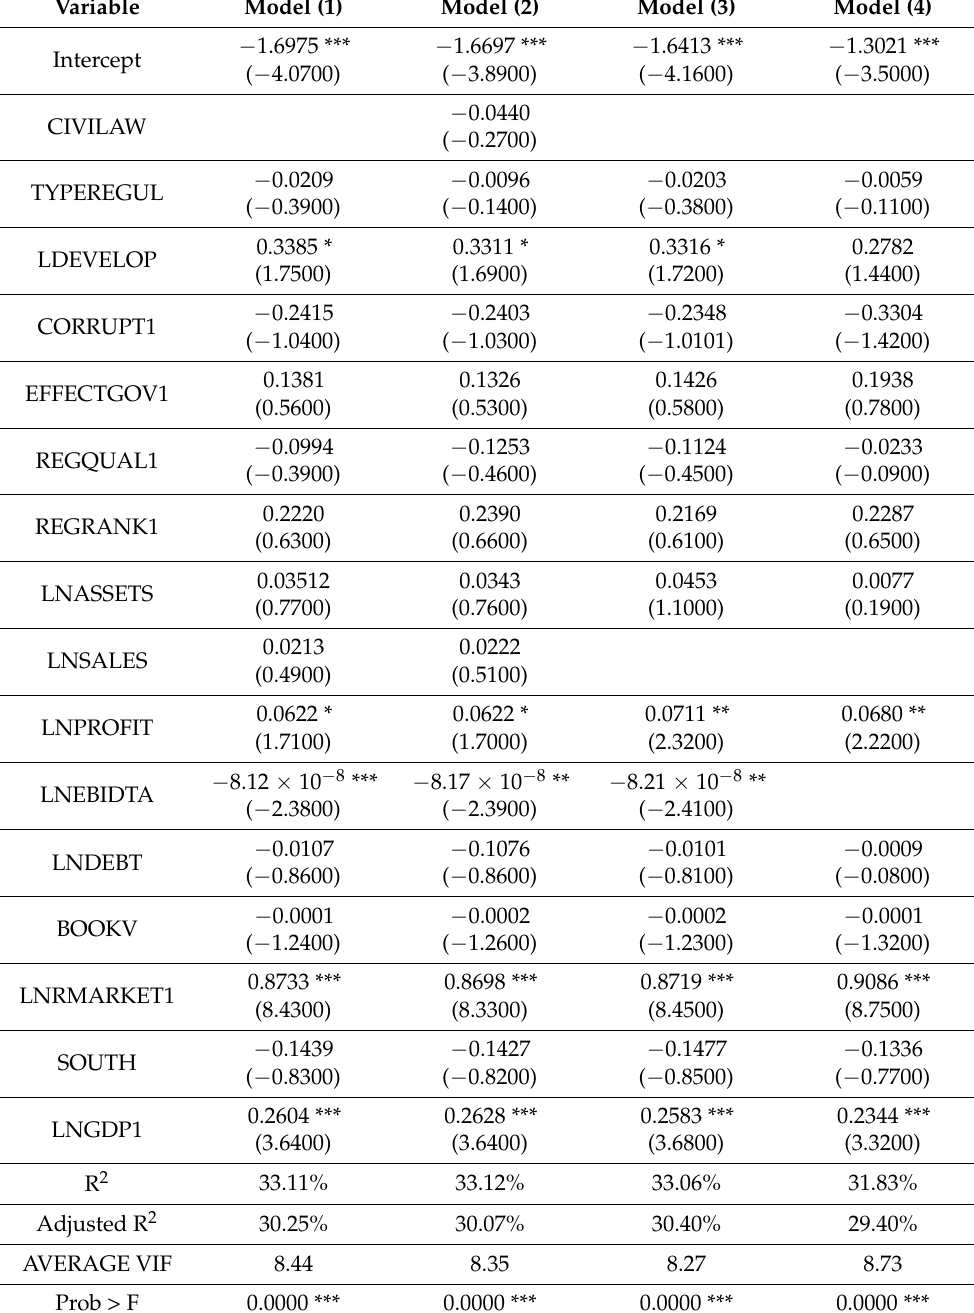
Table 6. First year return—LNBHR1—results